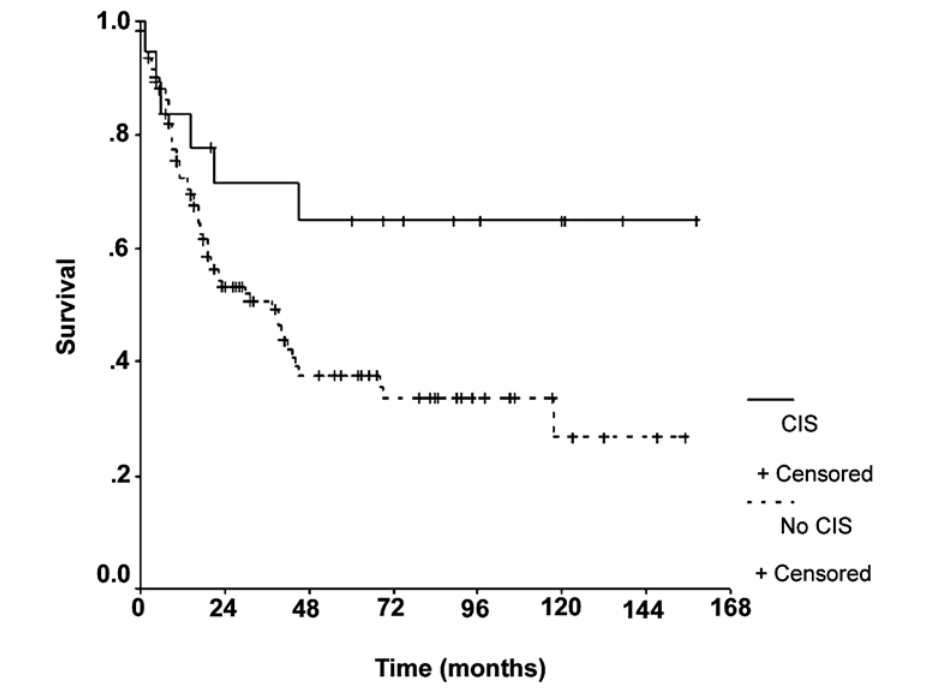
Figure 6 – Disease specific survival by presence of carcinoma